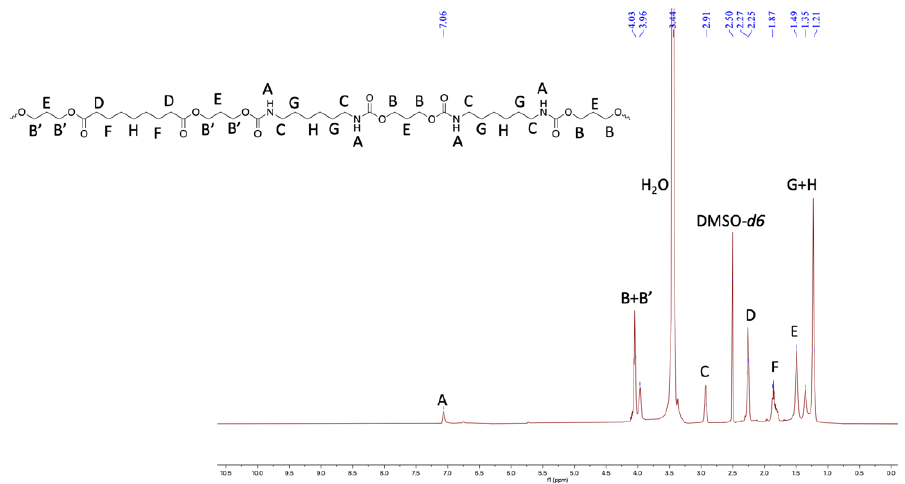
Figure 2. FTIR spectra for TPUs.